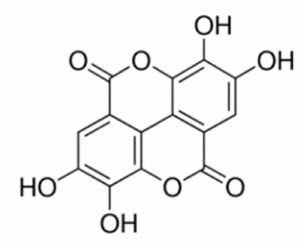
Figure 1. Ellagic acid (EA).